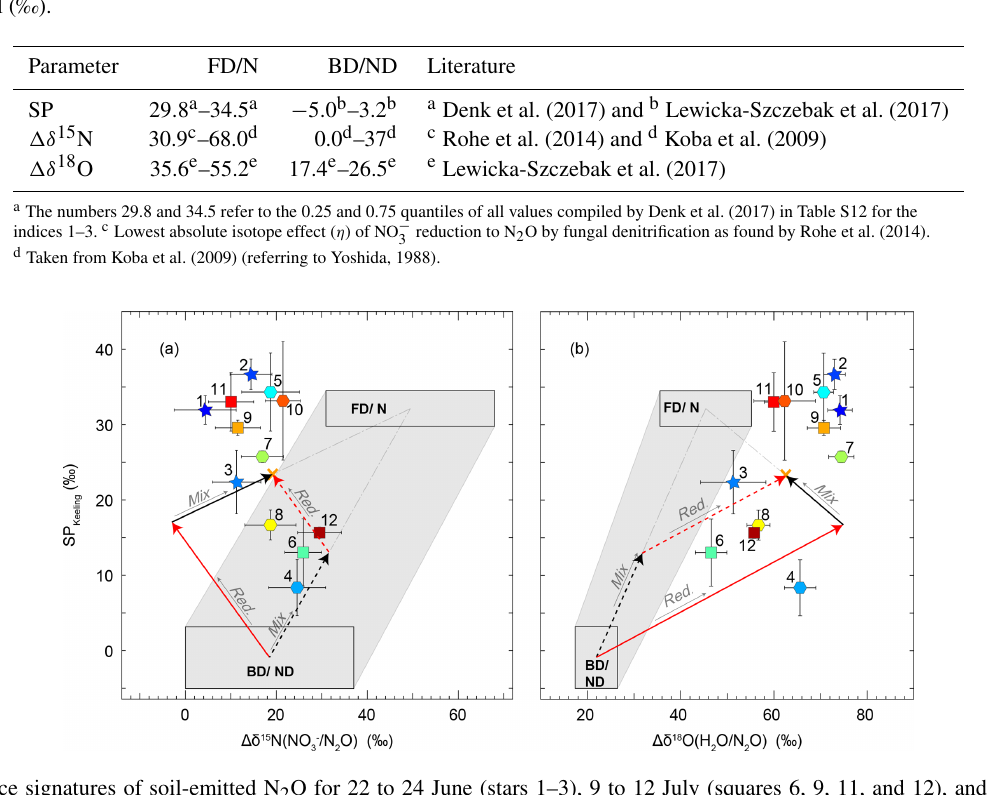
18 O − δ 15 N-N 2 O. (b) SP versus (cid:49)δ 3